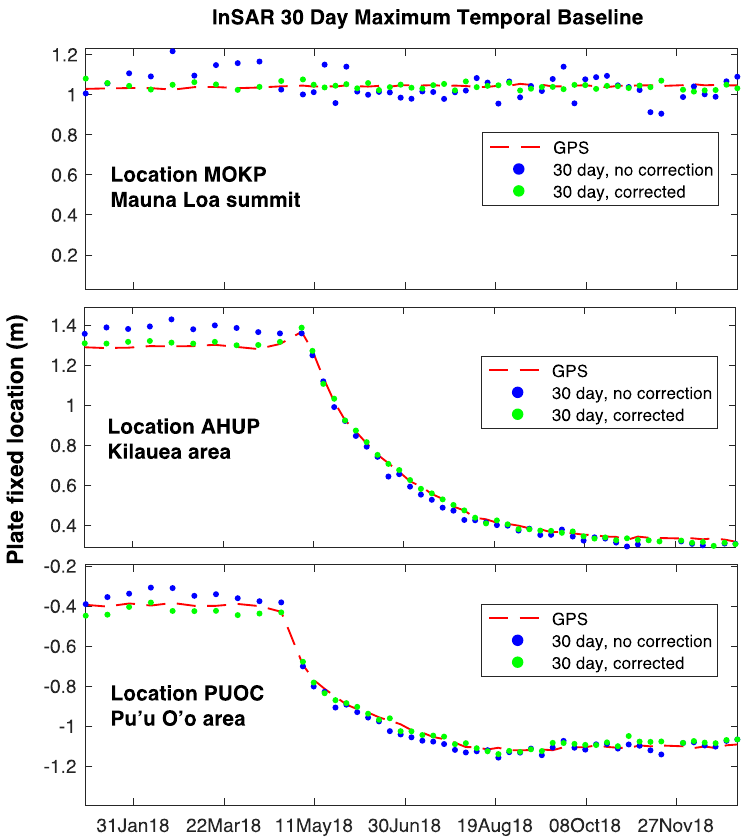
Figure 4. GPS/InSAR comparisons in the three study areas. Dashed red line is plate-fixed GPS location, blue dots are InSAR time series without the proposed atmosphere correction, and green dots are with the correction applied. Solutions here are for an unconstrained SBAS solution with maximum 30-day temporal separation, values for remaining GPS sites and with maximum baselines of 12 and 100 days are summarized in Table 1.